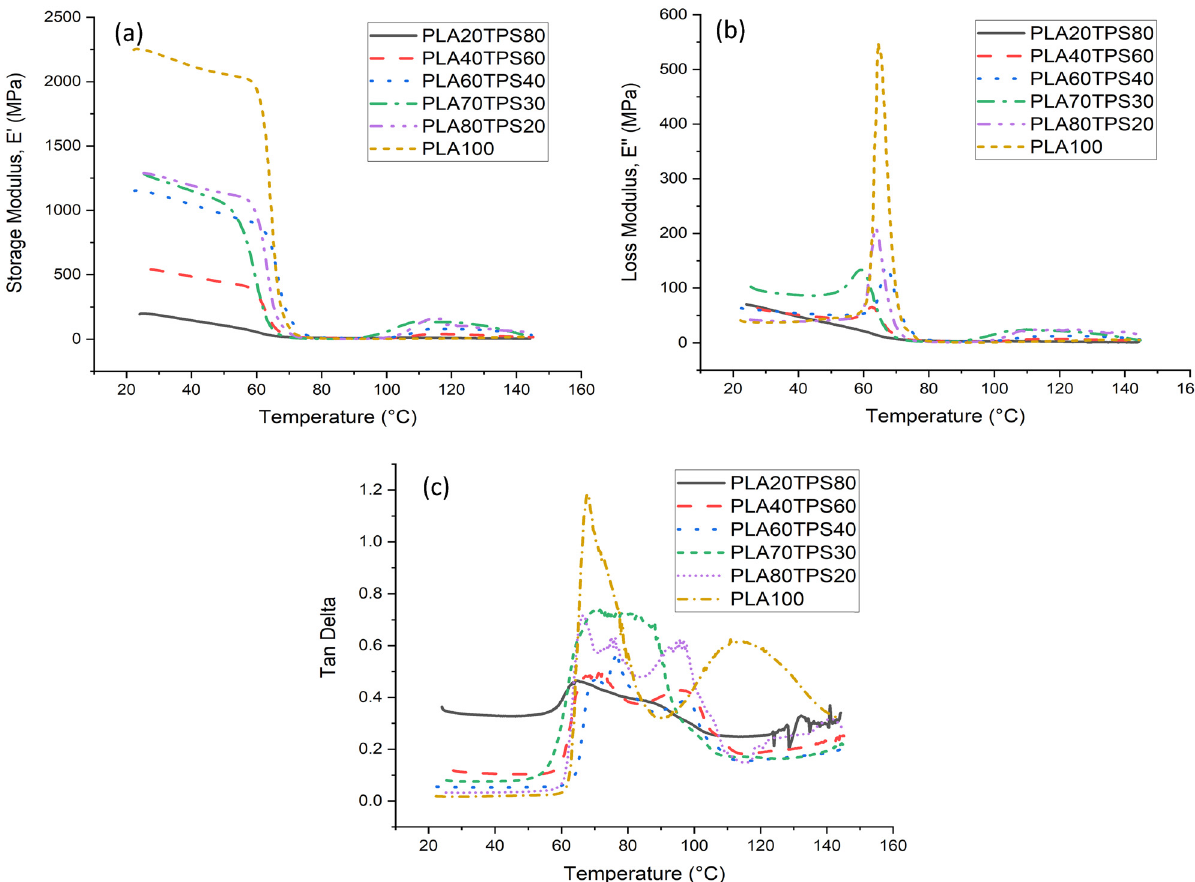
Figure 3: ( a ) Storage modulus, ( b ) loss modulus, and ( c ) tan δ of neat PLA and PLA/TPS blend